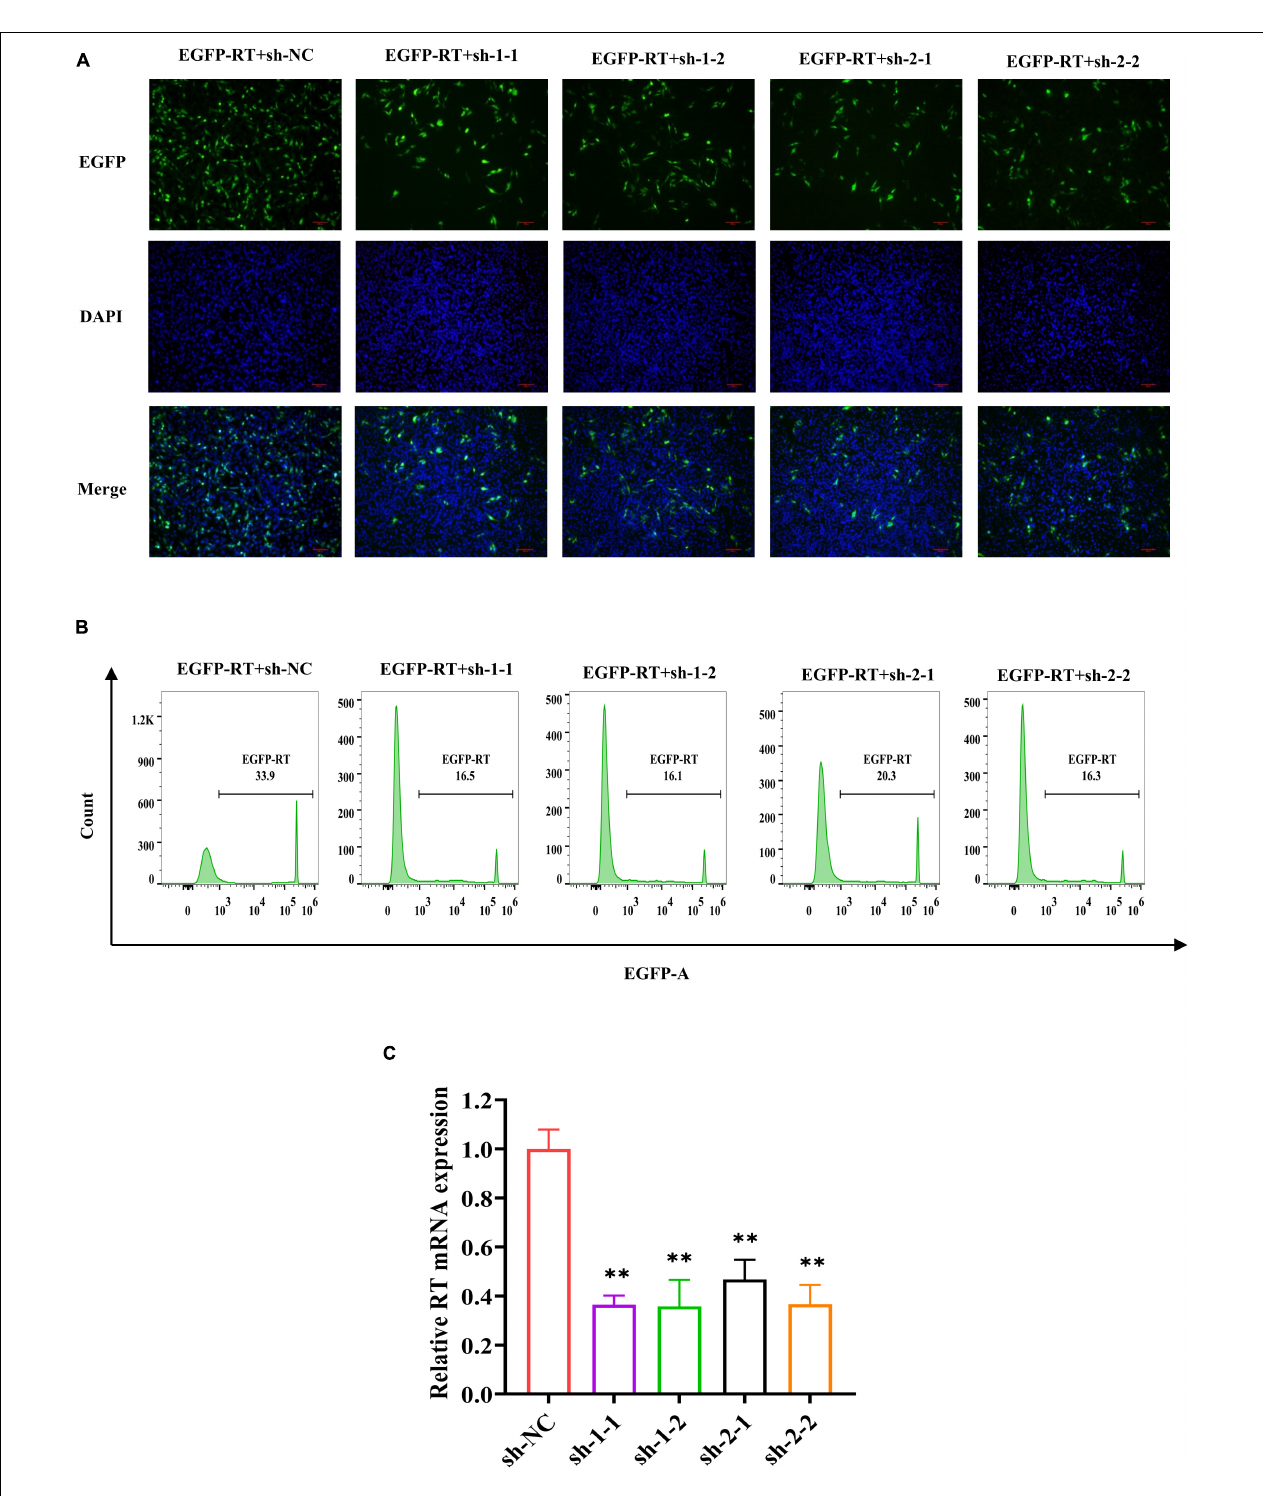
FIGURE 3 | Specific shRNA inhibits RT RNA transcript levels and RT-EGFP fusion protein expression. (A) EGFP fluorescence in DF-1 cells co-transfected with RT-EGFP fusion protein expression plasmid and shRNA expression plasmid were observed (magnification, × 200) at 48 h post-transfection. (B) The percentage of EGFP-positive cells was determined by a flow cytometer. The x -axis represents the fluorescence intensity of EGFP, and the y -axis represents the EGFP-positive cell count. The criterion of positive cells was that the fluorescence intensity of DF-1 cells was higher than 10 3 . (C) Quantitative analysis of relative RT mRNA expression in DF-1 cells. The RNA transcript levels were determined by real-time PCR and normalized to β -actin . The experiment was repeated three times. The error bars represent the SD. ∗∗ P < 0.01 and ns represents not statistically significant.